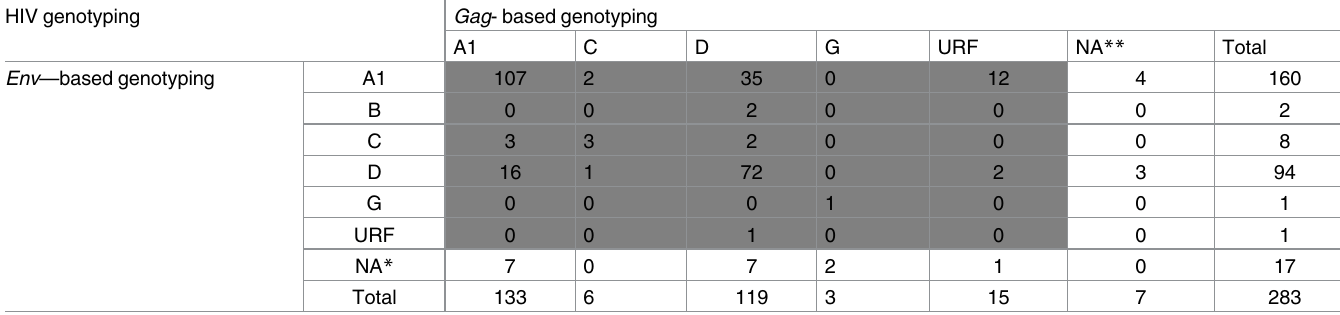
283 individualswith sequences in gag and/or env gene regions. URF Unique Recombinant Form sequences; NA * not amplifiable in env